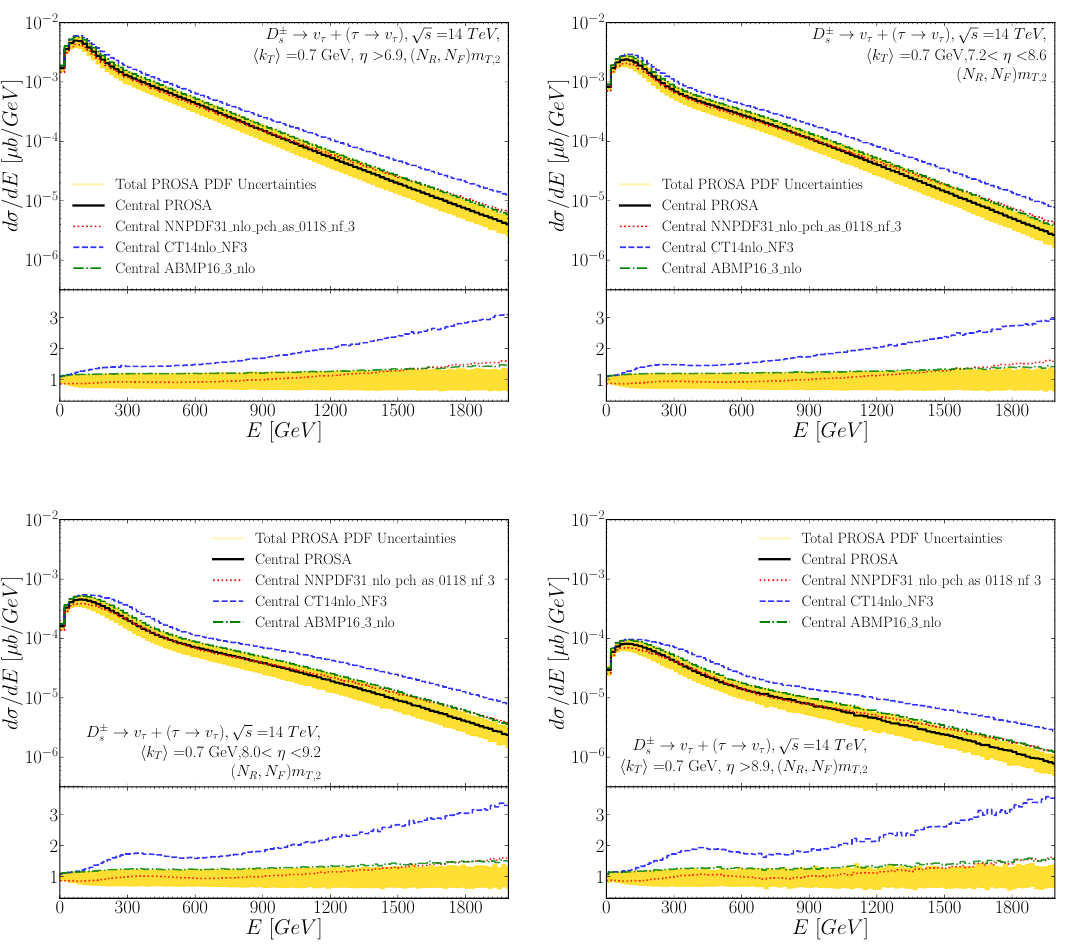
Figure 12. The PROSA PDF uncertainties in the NLO distribution of tau neutrino energy in the pseudorapidity range η ν > 6 . 9 (upper left), 7.2 < η ν < 8.6 (upper right), 8 . 0 < η ν < 9 . 2 (lower left) √ and η ν > 8 . 9 (lower right), respectively, for pp collisions at s = 14 TeV. The PROSA uncertainty envelope is shown in yellow in each panel. The red dotted, green dashed, blue dot-dashed curves correspond to the ratio of the NNPDF3.1, CT14 and ABMP16 NLO predictions to the central PROSA NLO